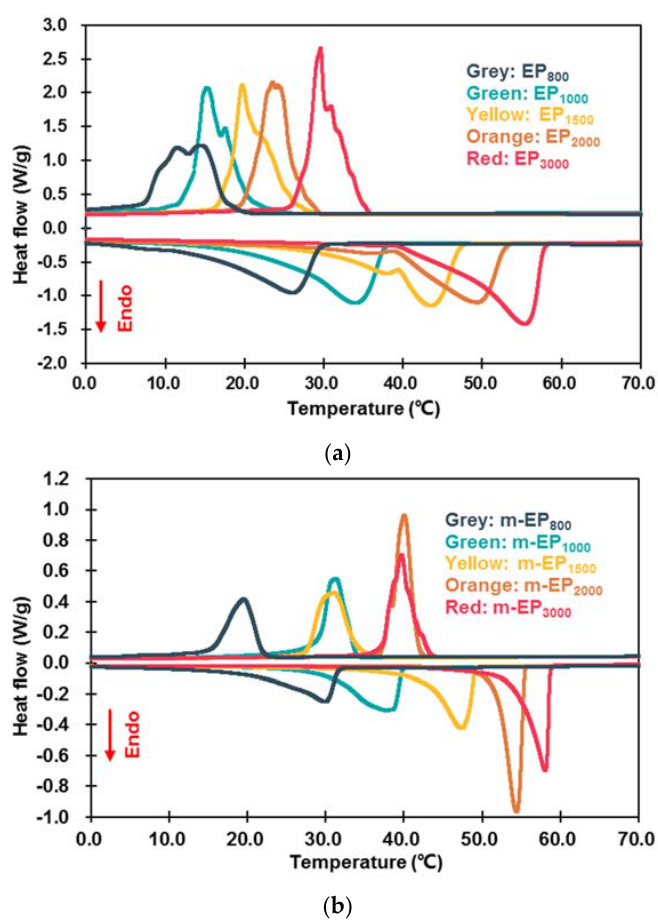
Figure 6. Differential scanning calorimeter (DSC) curves of EPs ( a ) and m ‐ EPs ( b ).